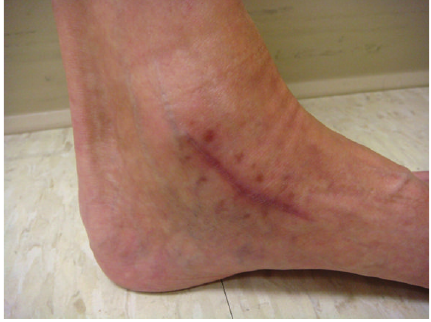
Figure 5: Palisading granulomas from the thigh and ankle regions.